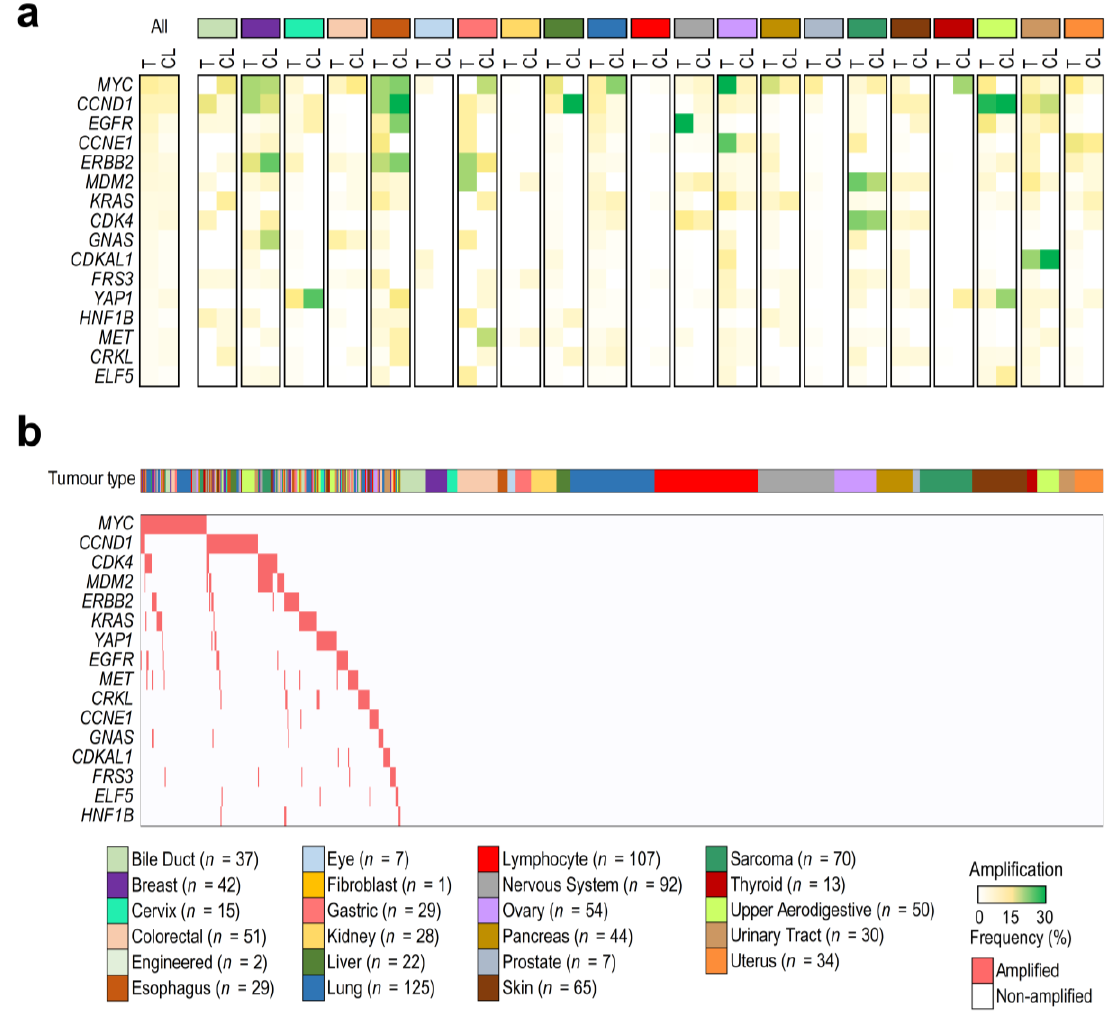
Figure 1. Cancer cell lines as models to study tumor gene amplifications. ( a ) Comparison of amplification frequencies between TCGA tumors (T) and DepMap cell lines (CL) from 21 lineages. A color gradient (from white to green) indicates the frequency of each amplification. ( b ) An amplification map of the DepMap cell lines ( n = 954) used in the study. Cell lines were classified by the lineage of origin and ordered by the presence (red) or absence (white) of each amplification (≥6 copies).